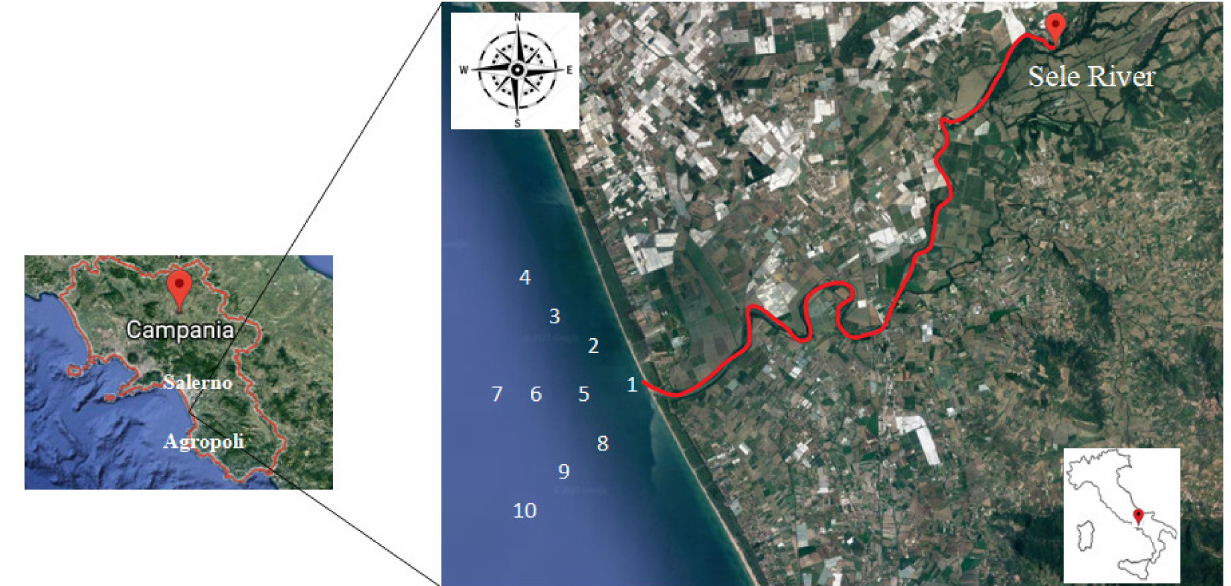
Figure 1. Map of the study area and sampling sites along the Sele River and estuary, southern